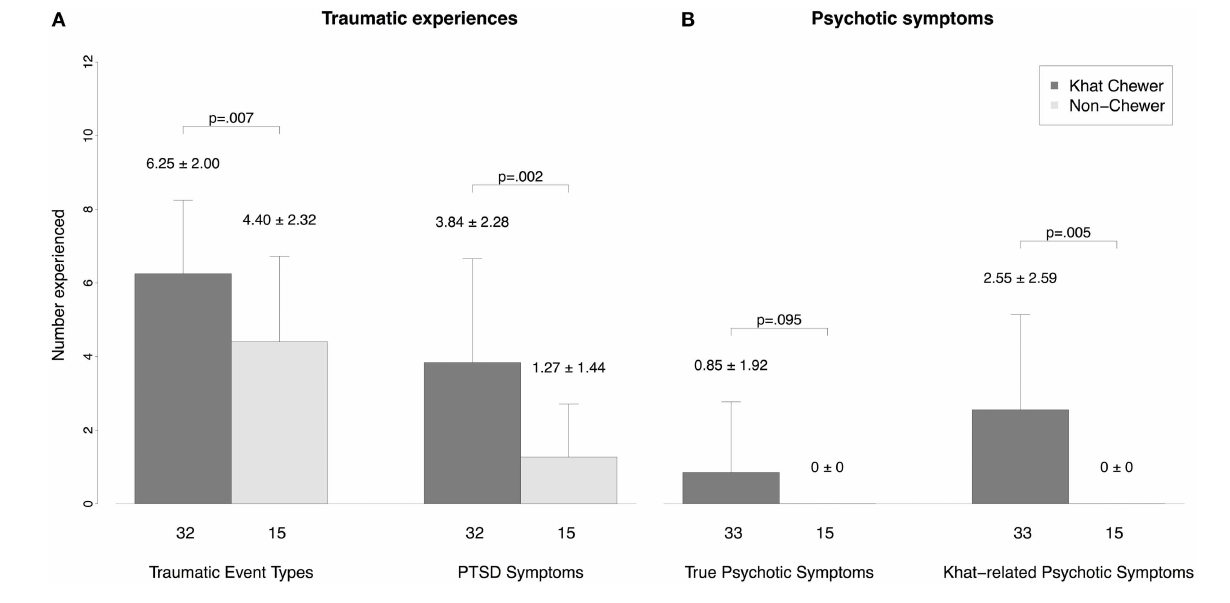
FIGURE 1 | Comparison of psychopathology between chewers and non-chewers . (A) Number of traumatic experiences and PTSD symptoms and (B) number of true psychotic symptoms and khat-related psychotic symptoms.We report means and standard deviations.